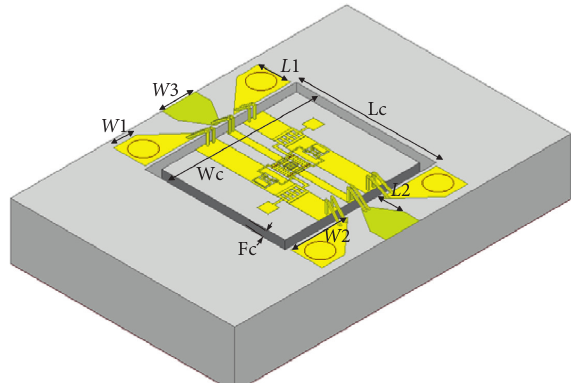
Figure 5: Transition structure of RF MEMS switch integrated in microstrip antenna.